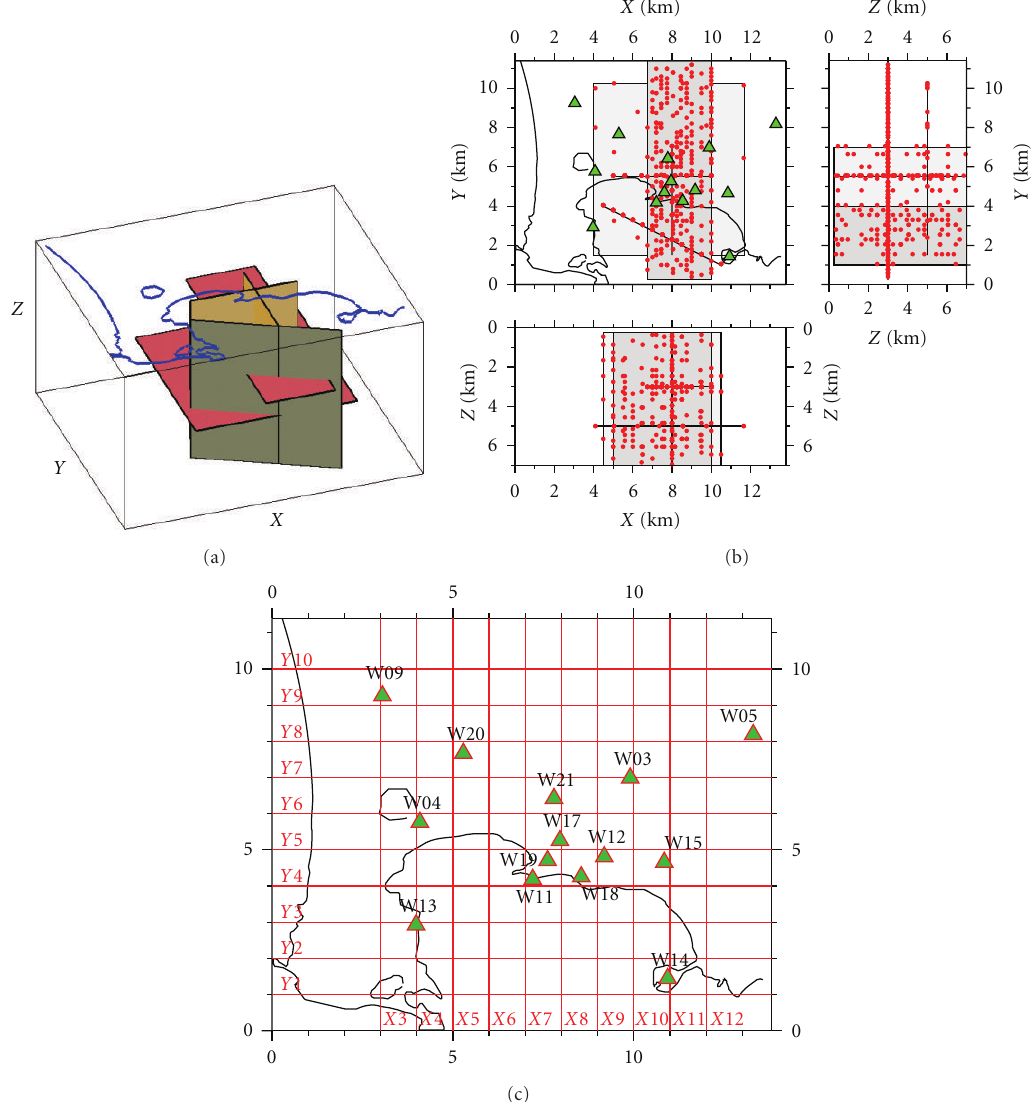
Figure 6: 3D model: location of the 550 sources. The five alignment planes of the sources can be identified both within the volume (a) and along three orthogonal projections (b). (c) shows the map of the receivers and the trace of the vertical sections along X and Y axes, respectively, which will be used to display the velocity fields. In (b), the virtual alignment planes of the sources have been highlighted by grey shaded areas and black